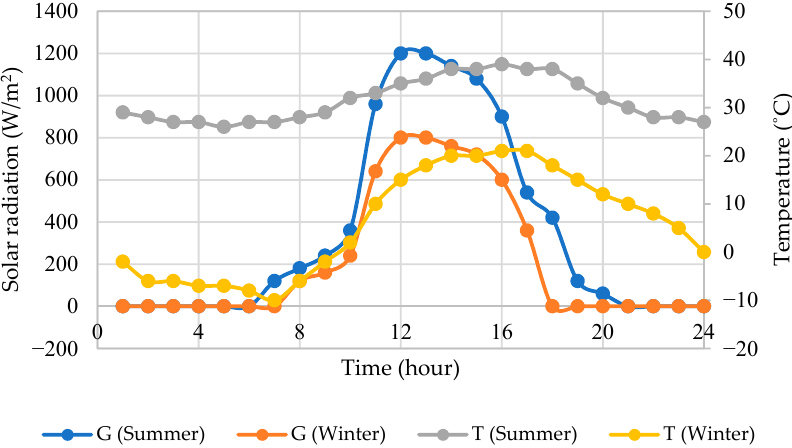
Figure 5. The hourly solar radiation and corresponding air temperature for summer and winter (Tehran, Iran).